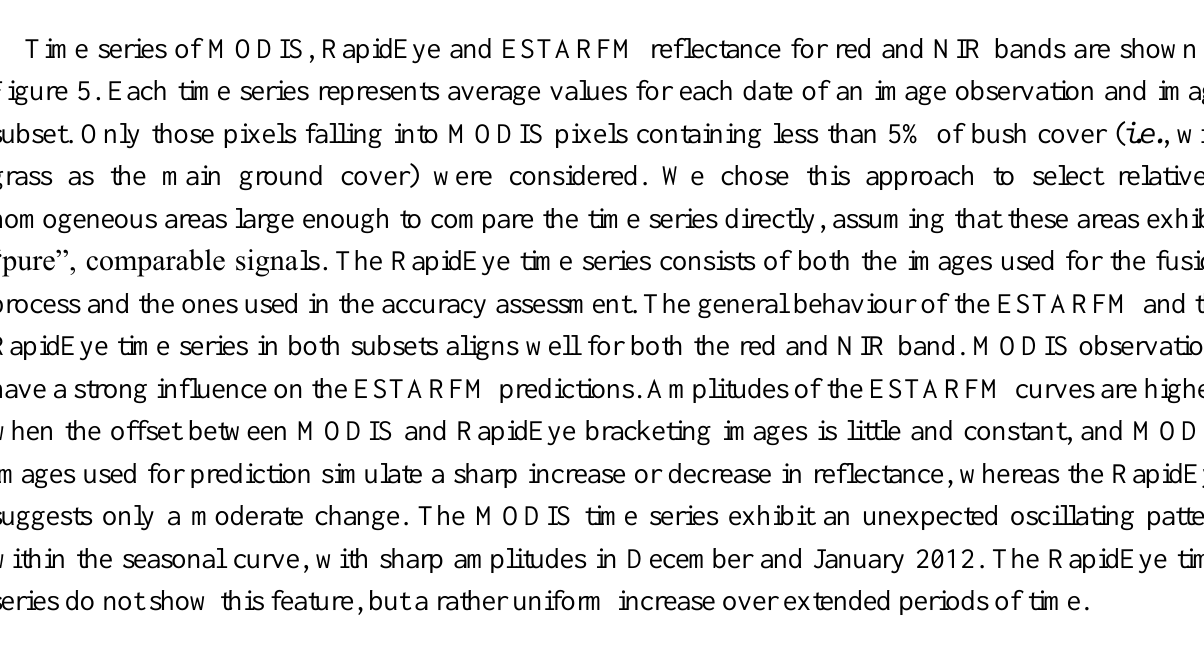
Figure 5. Each time series represents average values for each date of an image observation and image subset. Only those pixels falling into MODIS pixels containing less than 5% of bush cover ( i.e. ,